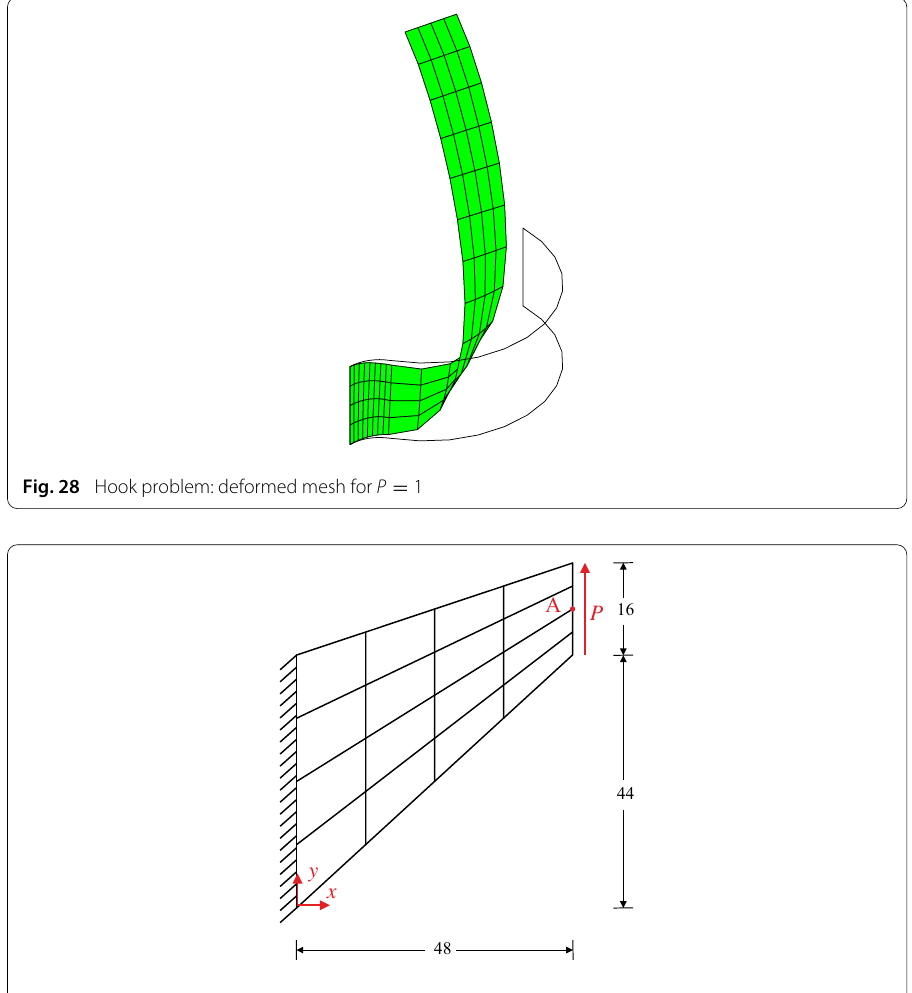
Fig. 29 Cook’s problem with a 4 × 4 mesh